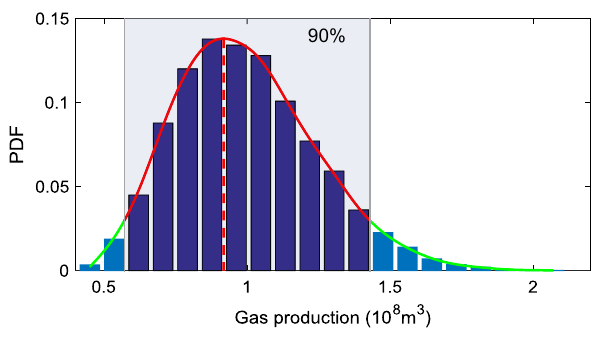
Fig. 5 Gas production and its probability distribution after 20 years of